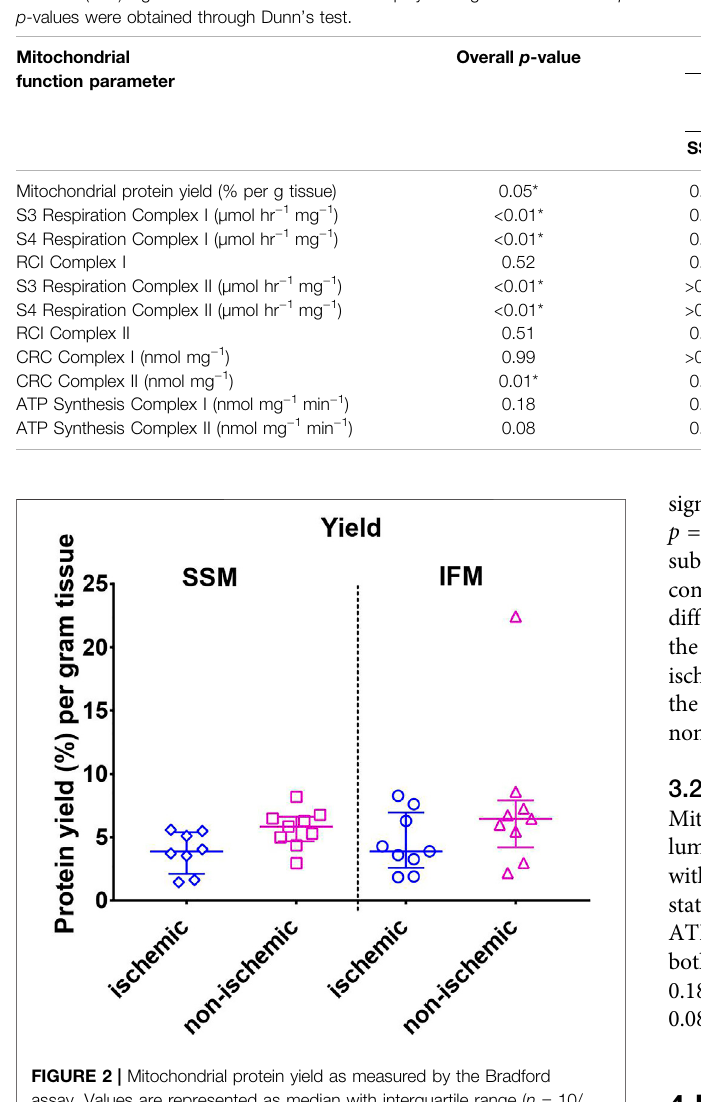
Frontiers in Cell and Developmental Biology |